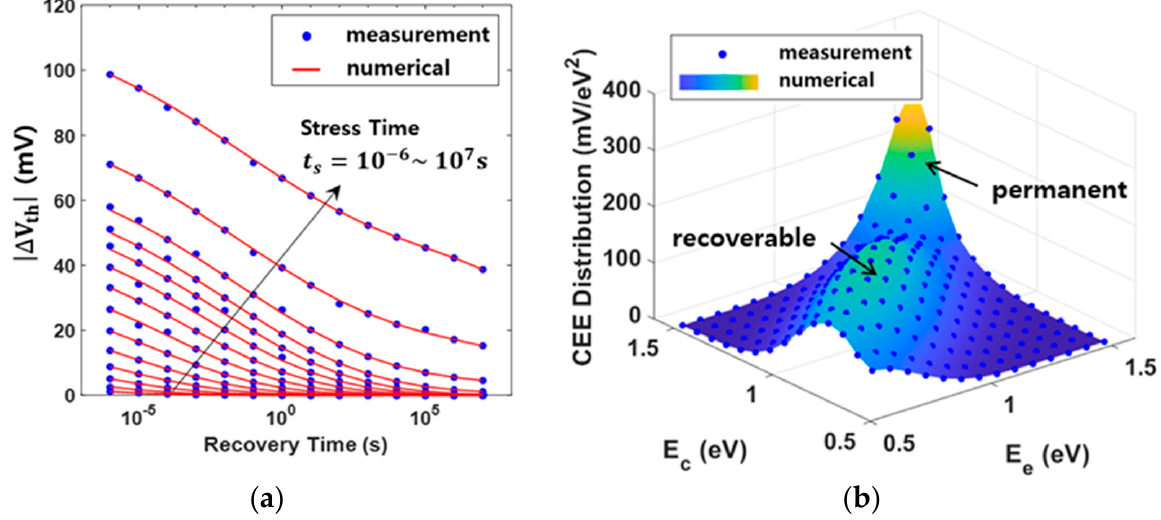
Figure 1. Threshold voltage shifts ∆ V th and capture-emission energy (CEE) map. ( a ) Numerical data with measured data of ∆ V th . ( b ) Comparison of numerical data with measured data of CEE map.